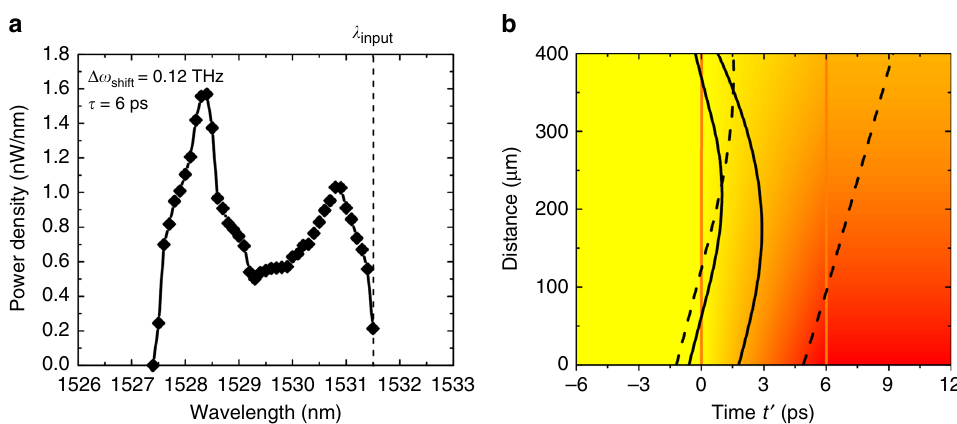
Fig. 5 Simulation of the FC front interaction with CW probe wave packets via ray tracing. a Wave packets average power spectrum for 6 µ W average power of the CW probe at 1531.5 nm, rising time of the front of 6 ps, and initial band shift Δ ω shift of 0.12 THz. Other parameters are listed in the Supplementary Note 6. b The trajectories of the probe wave packets with respect to the front velocity. The two vertical orange lines represent the extent of the index front with a rise time of 6 ps, while the shading represents the refractive index front as it exponentially decays during propagation inside the waveguide. comparison, original uncorrected curves are presented in the Supplementary Fig. 4. Here we show the trajectories of only four wave packets for clarity. Solid black lines represent those wave packets that undergo complete transitions, while the dashed lines depict the wave packets which only undergo incomplete transitions. We can see clearly that after interaction with the front some wave packets are accelerated by the front and bounced in the forward direction (solid lines) and some other wave packets still have velocities smaller than the front (dashed lines). In addition, we can observe that some wave packets starting initially inside the front are accelerated but do not have the enough time to leave the front.